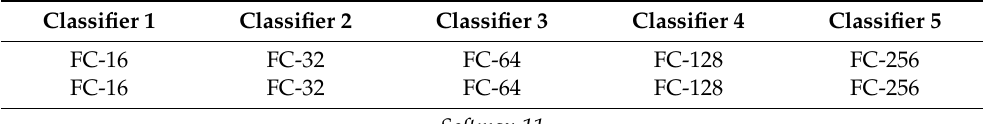
Table 4. Tested classifiers (FC- C is a fully connected layer with C neurons, and Softmax- D is a softmax layer with D